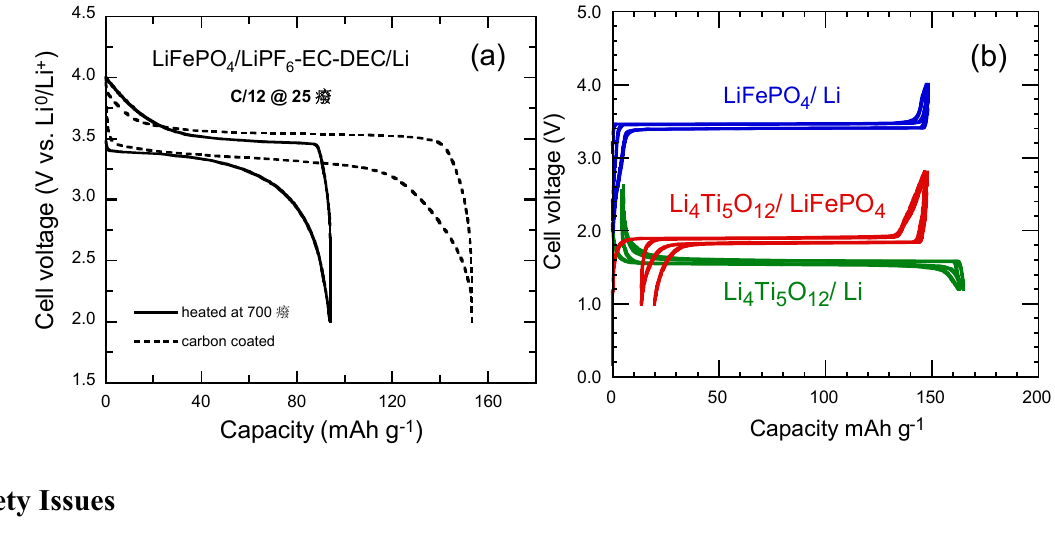
Figure 8. ( a ) Electrochemical performance of the LiFePO //Li coin cell operating at room 4 temperature before and after carbon coating. Charge-discharge cycling was conducted at //Li, Li Ti O //Li and Li-ion cell the C/12 rate. ( b ) Voltage-capacity cycle for LiFePO 4 4 5 12 LiFePO //Li Ti O at C/24 rate [62]. The capacity is in mAh per gram of the positive 4 4 5 12 electrode element (LiFePO , Li Ti O and LiFePO , respectively). The larger hysteresis in 4 4 5 12 4 the LiFePO //Li Ti O cell comes from the fact that the cell in that case was a button cell 4 4 5 12 instead of the more elaborate 18650-cell, but the plateau at 1.9 V is well observed. All the in EC:DEC (1:1) as cells used 1 mol L − 1 LiPF 6